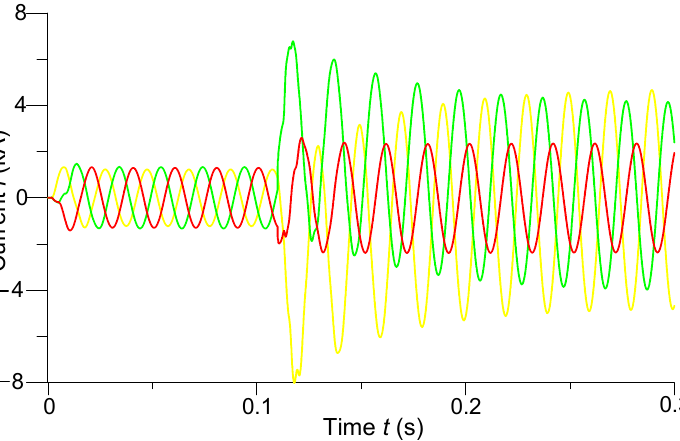
Figure 5. Transient processes of phase currents at the end of the line.